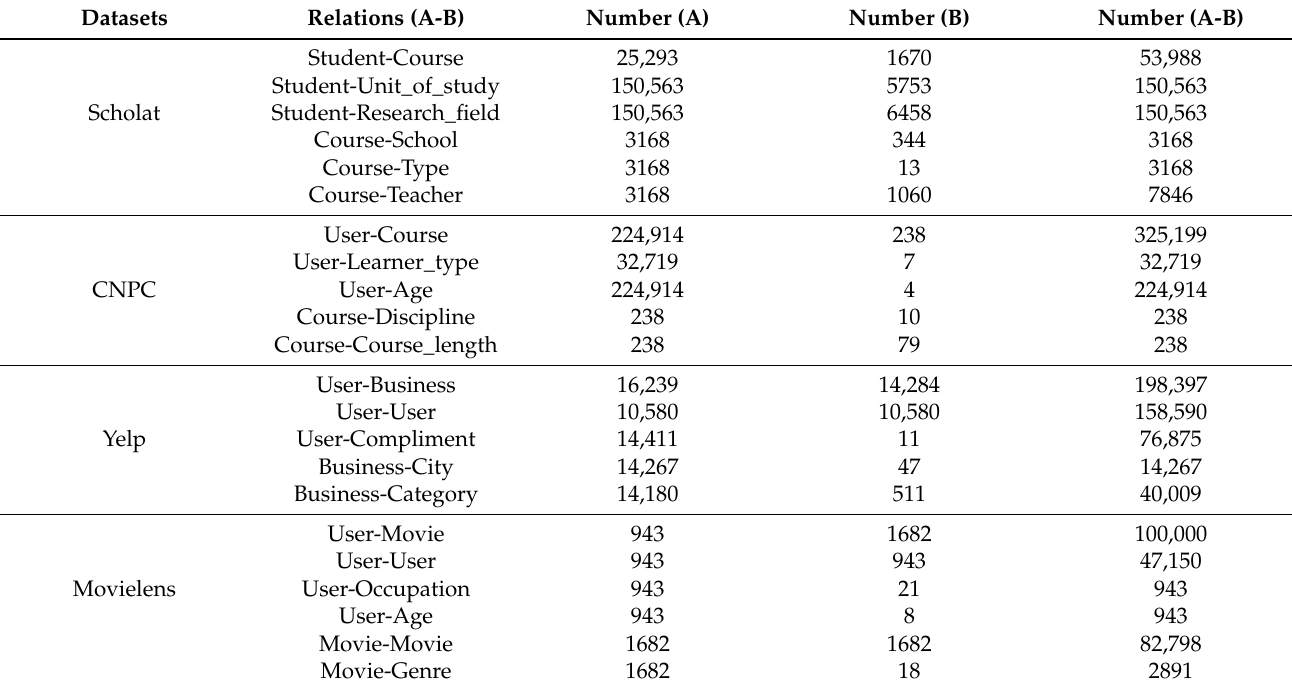
Table 2. Statistics for nodes and relationships in the